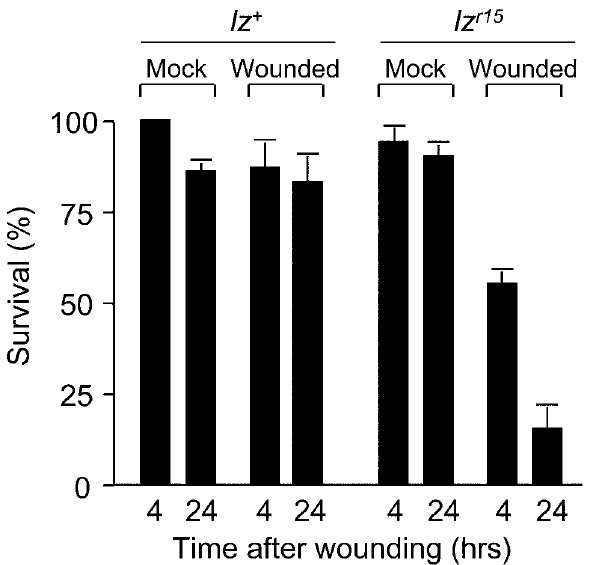
Figure 7. Effect of lz on Survival Following Puncture Wounding Control lz þ ( w 1118 ) and lz r15 mutant larvae were puncture wounded or mock-wounded and cultured for 4 or 24 h. The percentage of treated larvae alive and motile at each time is shown. Values are the average ( 6 standard error of the mean) of three to six independent experiments with ten or more treated larvae per time point. DOI: 10.1371/journal.pbio.0020239.g007